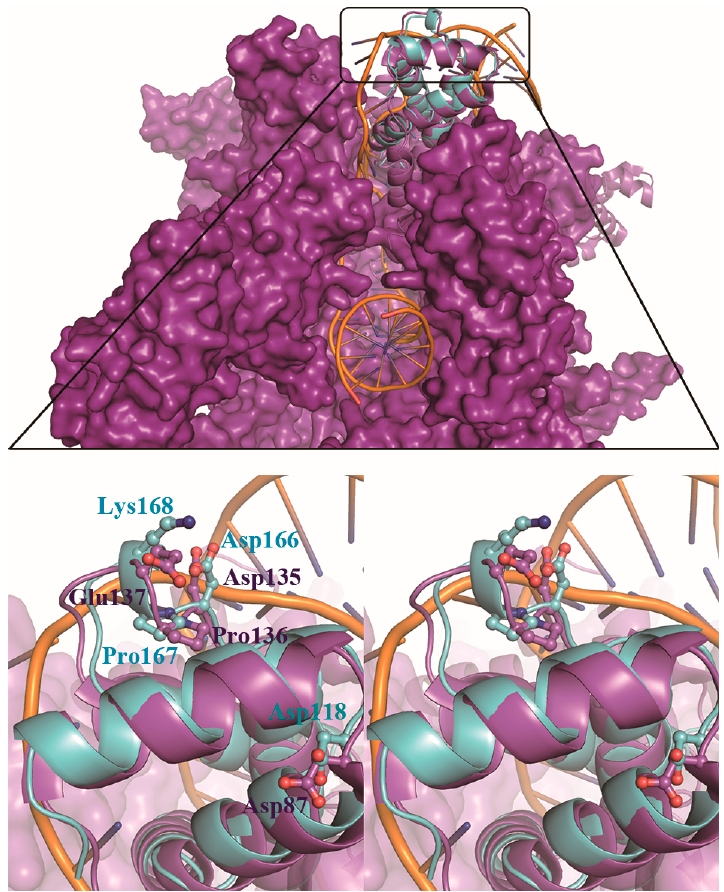
Figure 3. Superposition of Crl binding site from Ec RpoS (purple) (PDB accession code 5ipl) with the corresponding site from Lp RpoS 95–195 (cyan). Lp RpoS 95–195 and Ec RpoS from E. coli RNAP holoenzyme are shown as cartoon in addition to the molecular surfaces of other E. coli RNAP subunits. DNA is marked in orange. The right picture is magnified view of the boxed region in superposition of Lp RpoS 95–195 and Ec RpoS. The key residues from Ec RpoS (Asp87, Asp135, Pro136, and Glu137) and the corresponding residues from Lp RpoS 95–195 (Asp118, Asp166, Pro167 and Lys168) are shown in stick form.